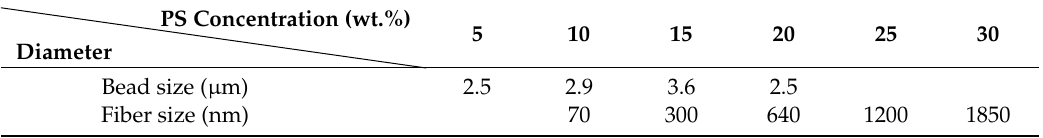
Figure 10. SEM micrographs of electrospun samples prepared using different PS concentrations in dimethylformamide (DMF) as solvent: ( a ) 5 wt.%, ( b ) 10 wt.%, ( c ) 15 wt.%, ( d ) 20 wt.%, ( e ) 25 wt.% and ( f ) 30 wt.%, adapted from reference [213]. Table 8. Effect of PS concentration on the average fiber diameter [213] .